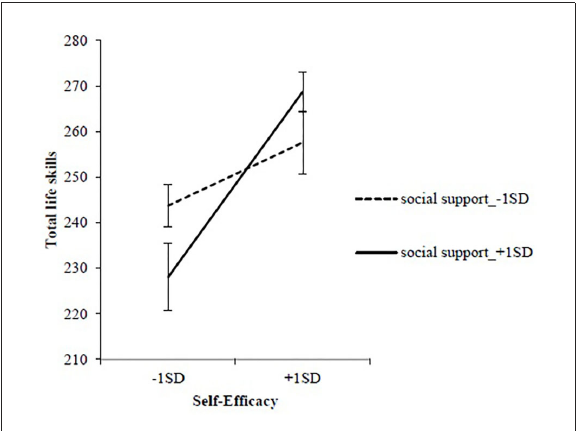
FIGURE2 The interaction between self-efficacy and social support related to total life skills in the action/maintenance